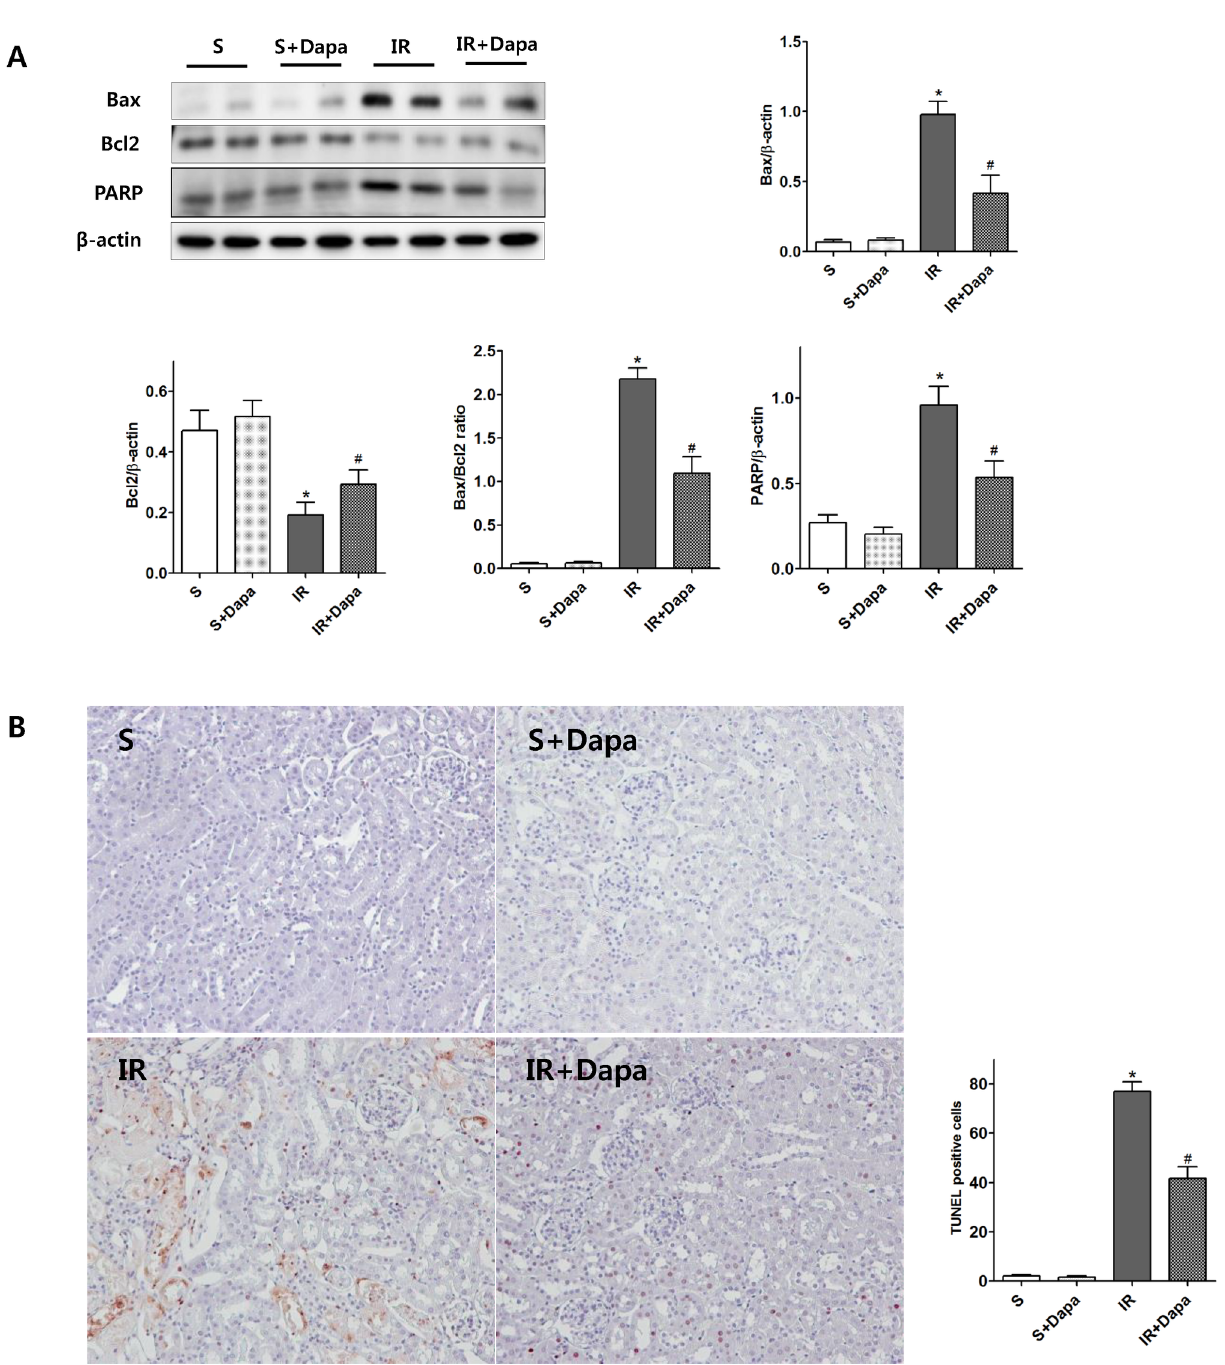
Fig 4. Effects of dapagliflozin on apoptosis in IR-injured kidneys (S(n = 5); S + Dapa (n = 5), IR(n = 7), IR + Dapa (n = 7)). (A) Western blot analysis shows dapagliflozin decreased Bax expression and increased Bcl2 expression in IR-injured kidneys. Dapalgliflozin decreased PARP expression in IR-injured kidneys. (B) Representative kidney section. Dapagliflozin decreased the TUNEL-positive cells in an IR-injured kidney. * P < 0.05 vs. sham kidney, # P < 0.05 vs. IR kidney. Bar represents mean ± s.d.